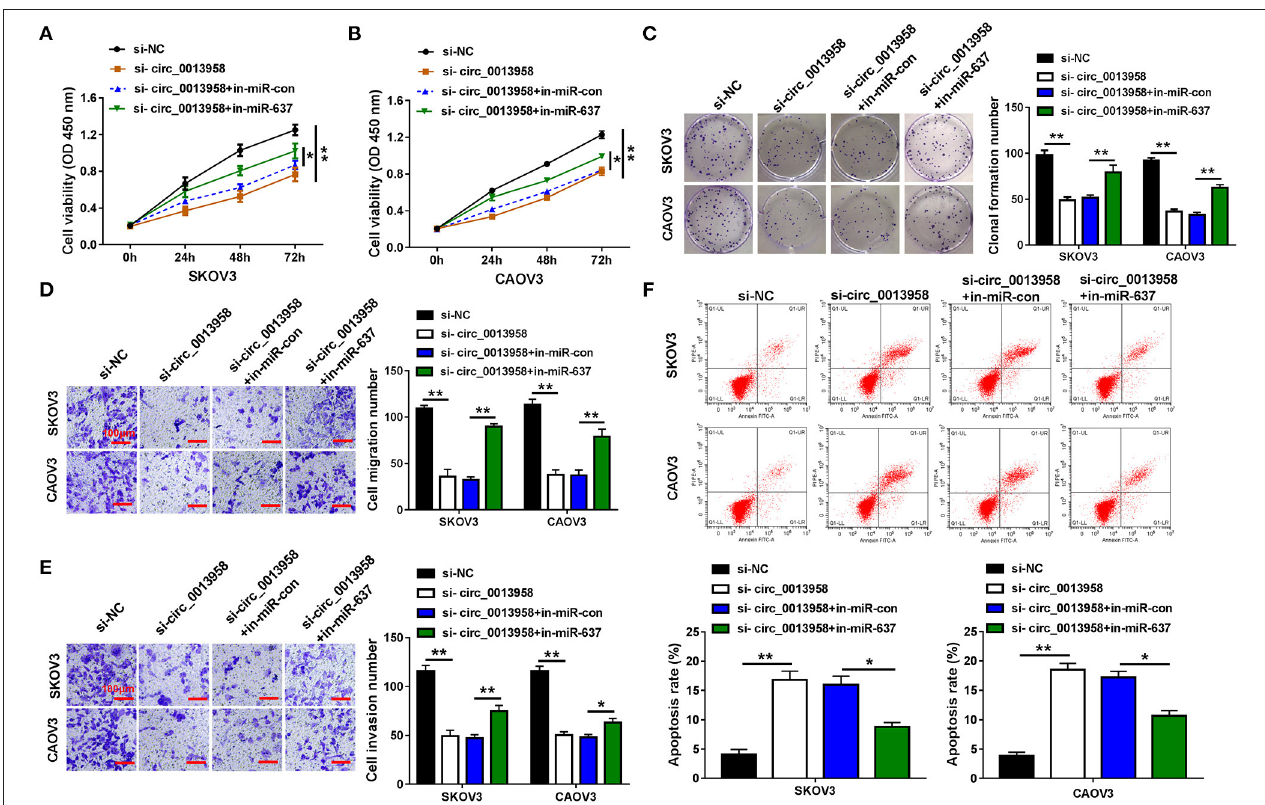
FIGURE 3 | Circ_0013958 knockdown inhibited proliferation, migration, and invasion but promoted apoptosis in OC cells by negatively regulating miR-637. SKOV3 and CAOV3 cells were transfected with si-NC, si-circ_0013958, si-circ_0013958 + in-miR-con, or si-circ_0013958 + in-miR-637, respectively. (A,B) CCK-8 assay for the cell viability of transfected cells. (C) Colony formation assay for the clonogenicity ability of transfected cells. (D,E) Transwell assay for the cell migration and invasion in transfected cells. The scale bar represents 100 µ m. (F) Flow cytometry for the apoptosis rate of transfected cells. * P < 0.05; ** P < 0.01.